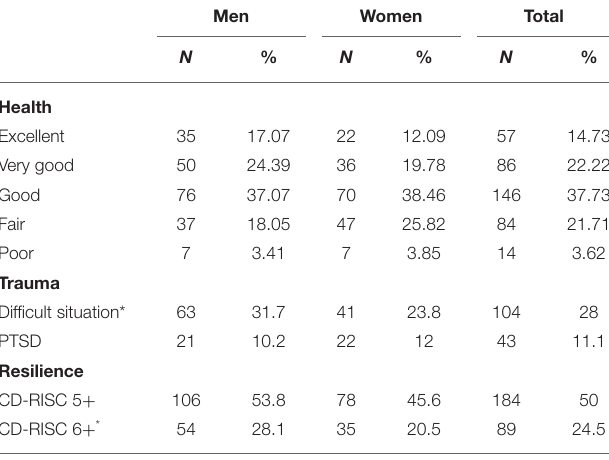
TABLE 6 | Frequency and percentage for general health, trauma and resilience, by gender. Men Women Total N %